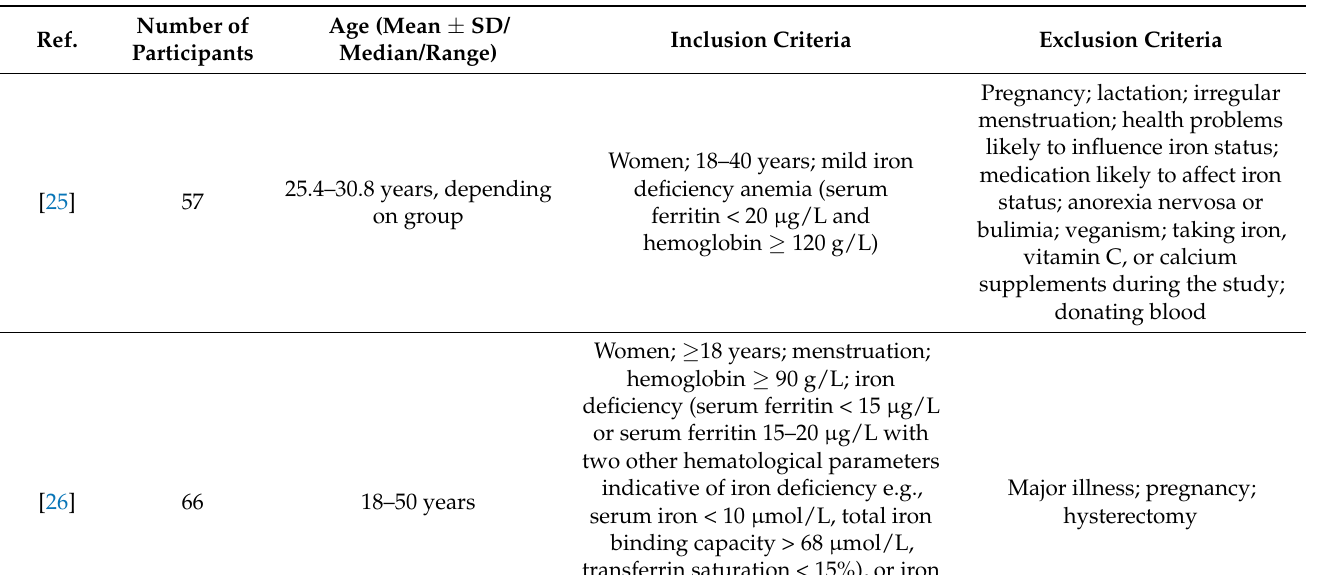
Table 4. The characteristics of the study participants of the randomized controlled trials included in the systematic